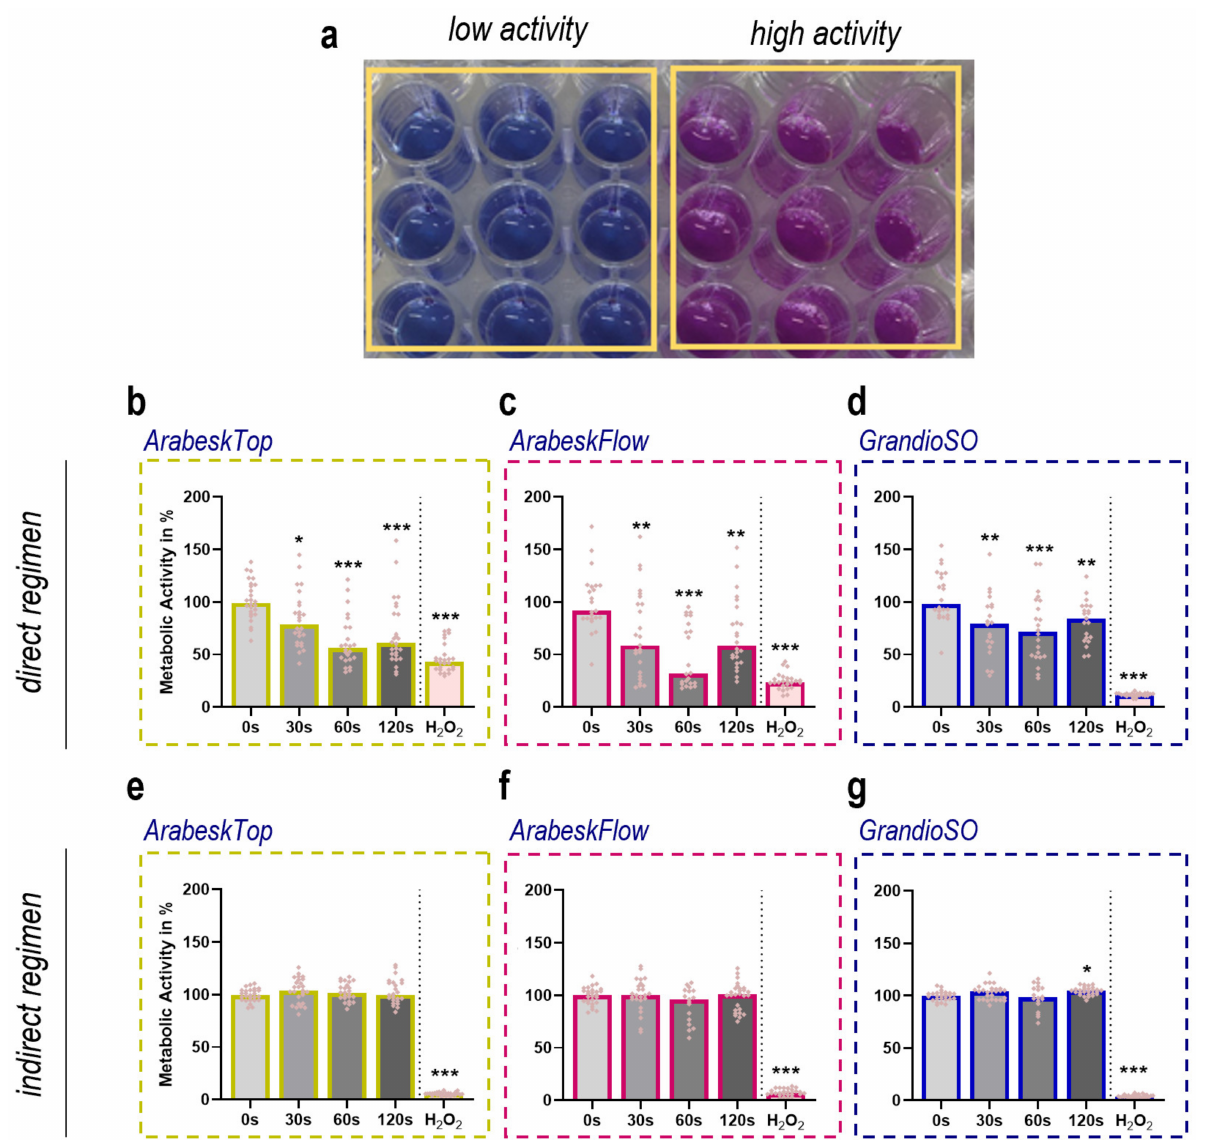
Figure 2. Human HaCaT keratinocyte metabolic activity. ( a ) representative wells of the resazurin- based assay as a measure of reduction equivalents present in cell cultures; ( b – d ) resorufin fluorescence of human HaCaT keratinocytes cultured in the presence of untreated (0 s) or gas plasma-treated ArabeskTop ( b ), ArabeskFlow ( c ), and GrandioSO ( d ) in cell culture media in 96-well plates for 24 h (direct regimen); ( e – g ) resorufin fluorescence of human HaCaT keratinocytes cultured in the absence of composite chips but in the presence of cell culture medium incubated for 24 h with untreated (0 s) or gas plasma-treated ArabeskTop ( e ), ArabeskFlow ( f ), and GrandioSO ( g ) composite chips (indirect regimen). Hydrogen peroxide (H 2 O 2 )-treated composite chips served as a positive control. Data are normalized to untreated (0 s) conditions and are mean of six independent experiments with three technical replicates each. Statistical analysis was performed using one-way analysis of variances with * = p < 0.05, ** = p < 0.01, and *** = p < 0.001 and Dunnett’s post-hoc test for untreated control conditions (0